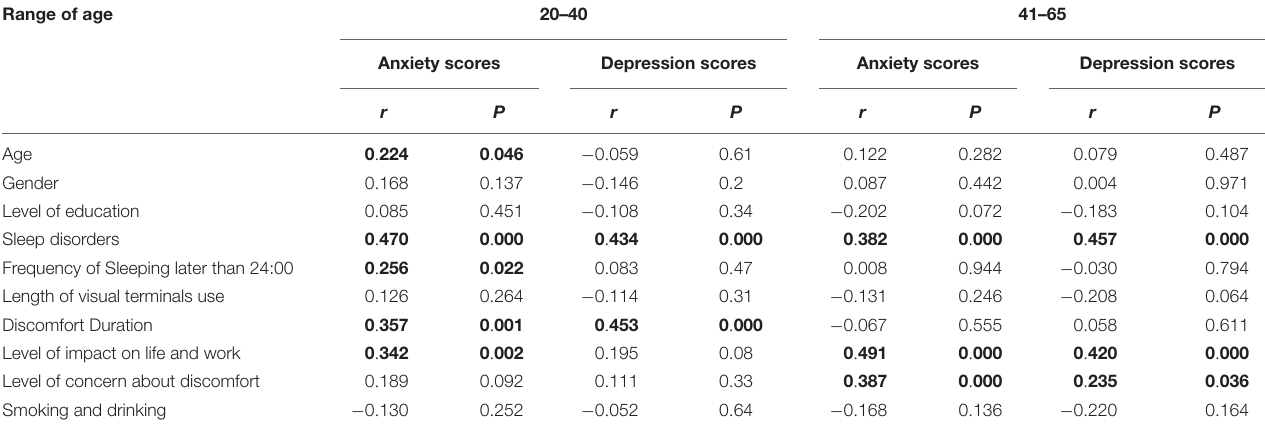
TABLE 4 | Correlation of demographic information with psychological disturbances for dry eye disease (DED) patients.